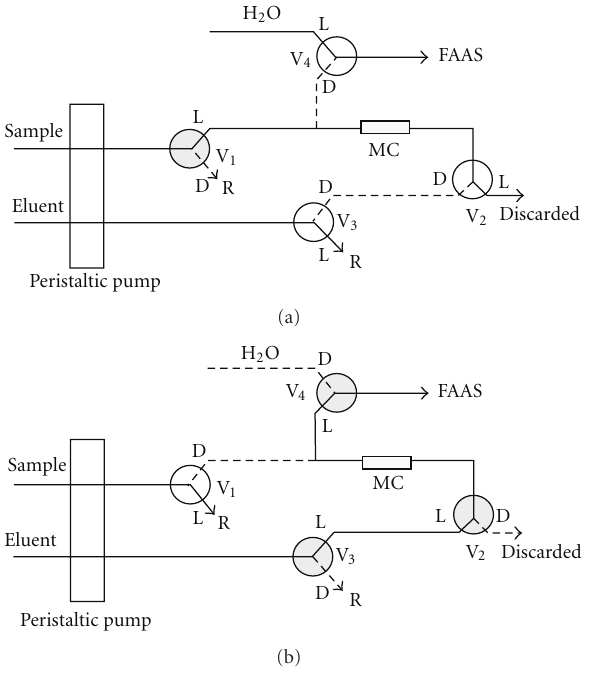
Figure 1: Diagram of the online preconcentration system used in this study. (a) Adsorption process and (b) desorption process. V, valve; L, open; D, closed; MC, minicolumn containing adsorbent; R, sample or eluent back stream; hatched circle, valve on; white circle, valve o ff .